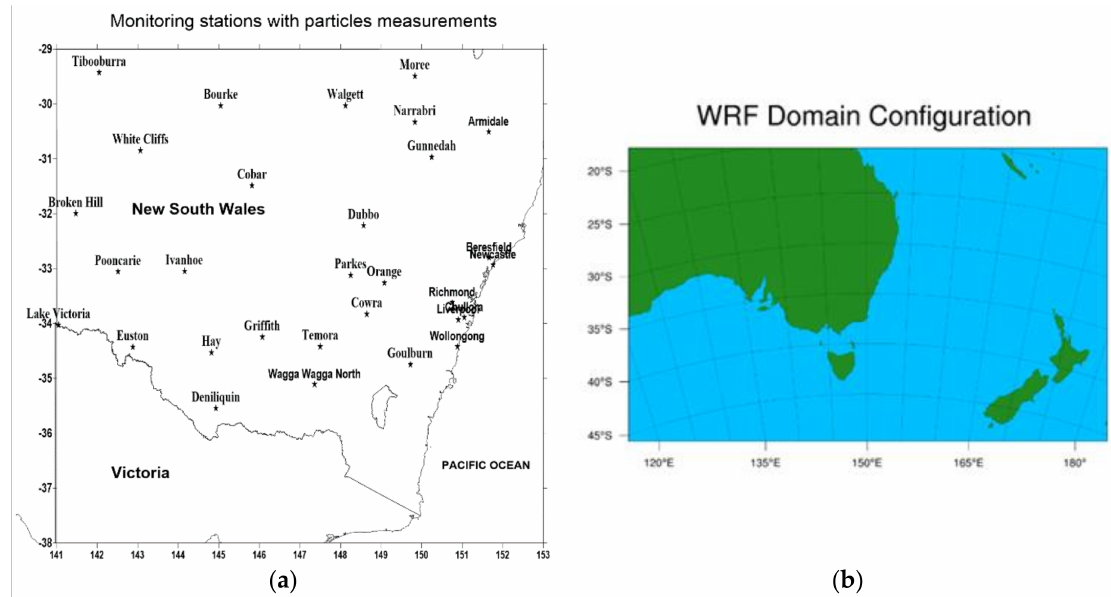
Figure 2. Location of some of DPIE air quality monitoring stations with dust particle measurements ( a ) and the WRF-Chem modelling domain ( b